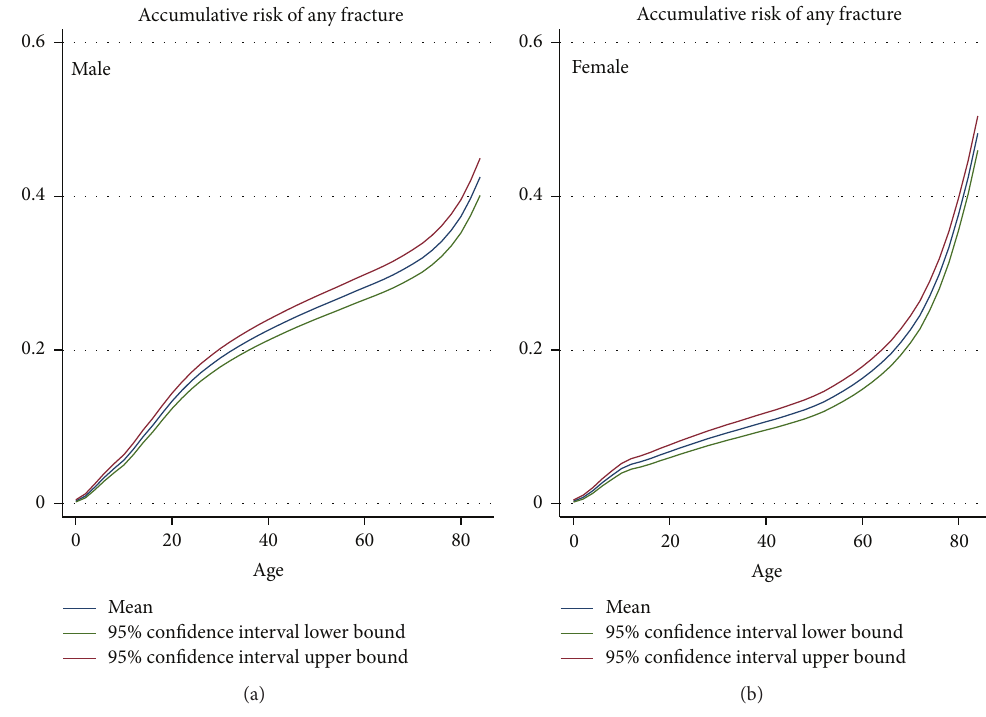
Figure 5: Cumulative risk of having any fracture hospitalisation since birth.